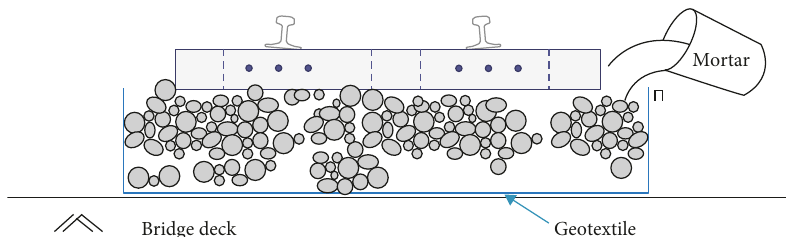
Figure 1: Concept of quick-hardening